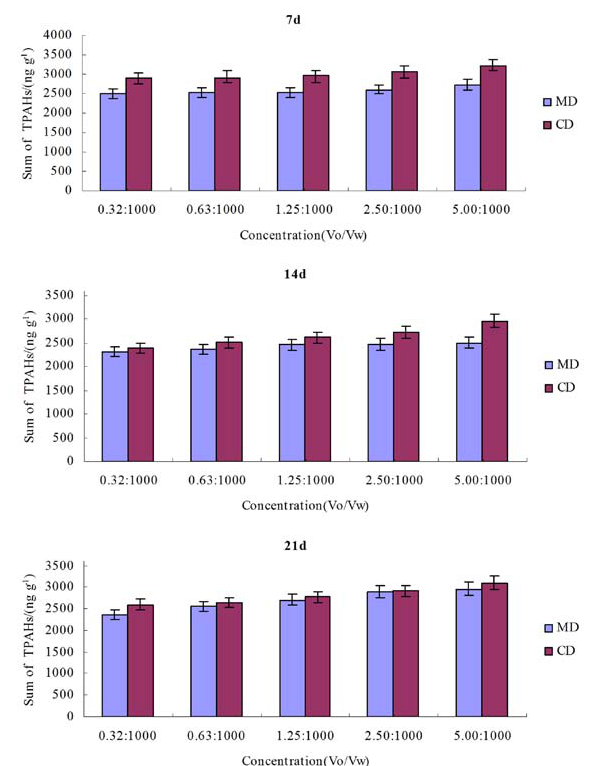
Fig. 2. – Concentration of total PAHs in chemically and mechani- cally dispersed water accommodated fraction of oil within different exposure times (7, 14 and 21 d).